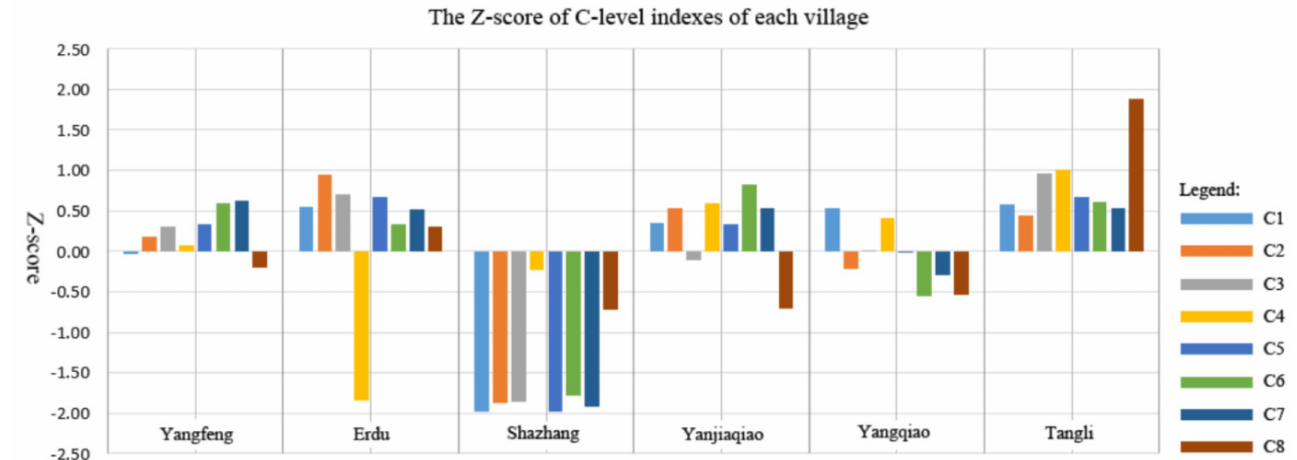
Figure 12. Normalized Z-scores of villages’ indicators at layer